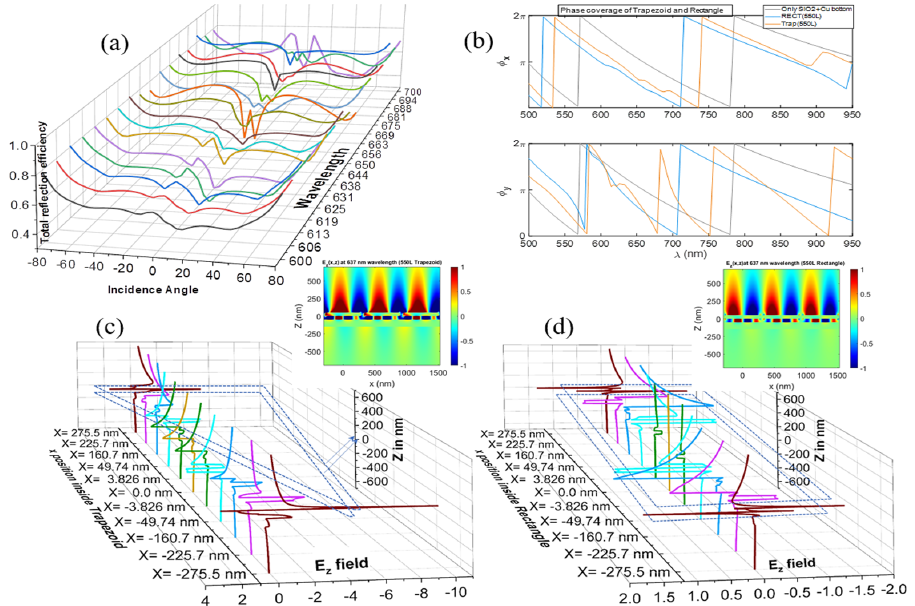
Figure 3. ( a ) The simulated TM incidence angle-dependent reflection efficiency for the 550L trapezoid in the wavelength range of 600 to 700 nm showing the normal incidence origins of the SPP waves; ( b ) a comparison of the wavelength-dependent phase profiles of the 550L trapezoid and rectangle; ( c ) the E z(z) field profiles at various x-positions within the trapezoid and ( d ) rectangle. The trapezoid was from z = 0 to 50 nm, the continuous SiO 2 layer occupied Z = − 50 to 0 nm and the Cu bottom layer was from z = − 150 to − 50 nm. The blue dashed line shows the structural outline. The inset shows the E z(x,z) field profiles of the three trapezoids in ( c ) and rectangles in ( d ). The relationship between the SPP dispersion through both the air–Cu and SiO 2 –Cu interfaces of the continuous layers of the metasurface is presented in Figures 4a and S2.1a.